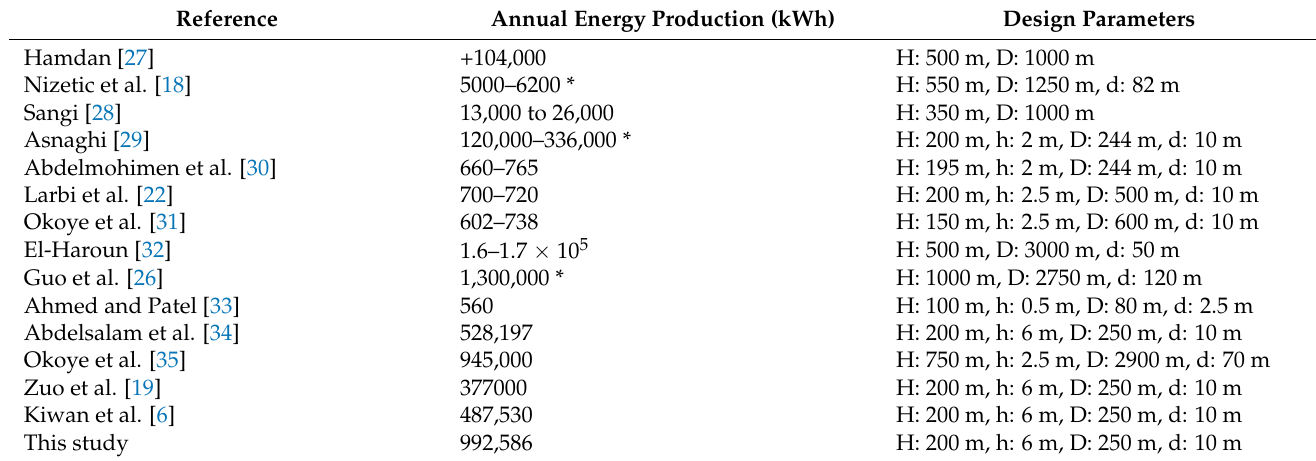
Table 5. Summary of the power generation from SCPP for different SCPP design